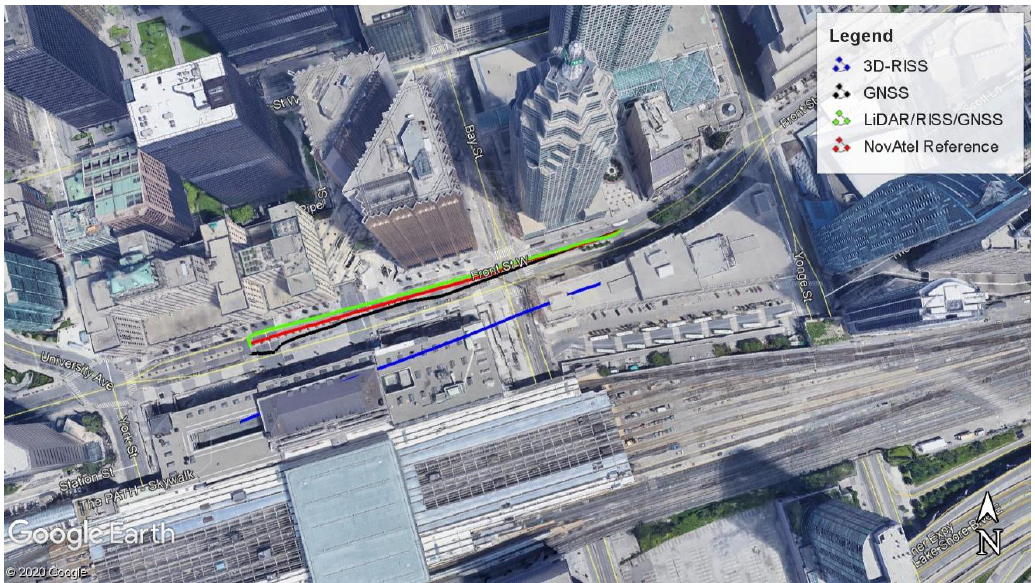
Figure 28. Navigation solution for 3D-RISS, GNSS, LiDAR/RISS/GNSS, and NovAtel Reference During the Scenario (Second Switch). Remote Sens. 2020 , 12 , x FOR PEER REVIEW